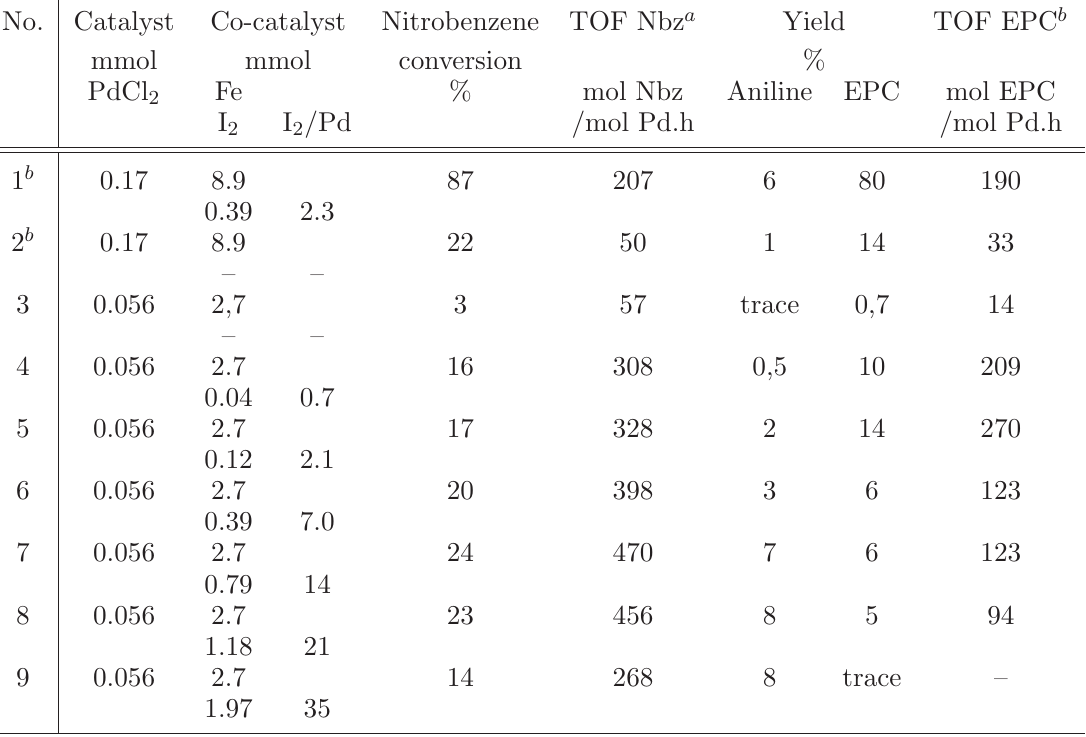
Table 3 The effect of the amount of iodine on reductive nitrobenzene carbonylation at a constant PdCl 2 /Fe/Py